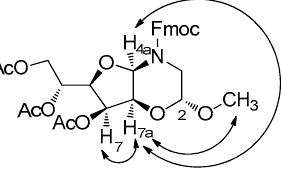
Figure 6. Selected nOe contacts from NOESY1D spectra of 21 .